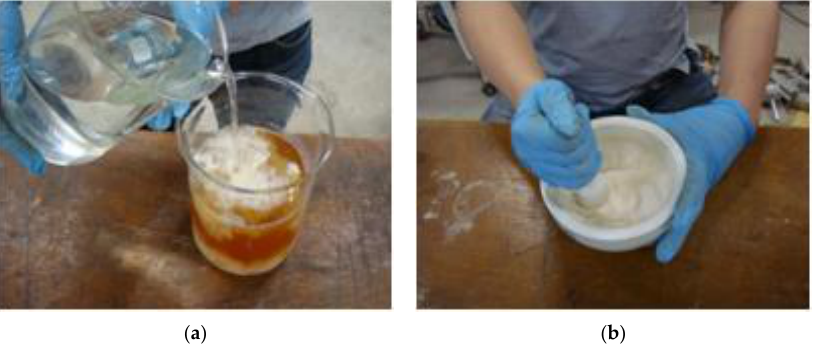
Figure 1. Making of the bio grouting material: ( a ) mix the microbial solution and the sodium silicate solution; and ( b ) make powder (calcium carbonate) in a bowl plate.